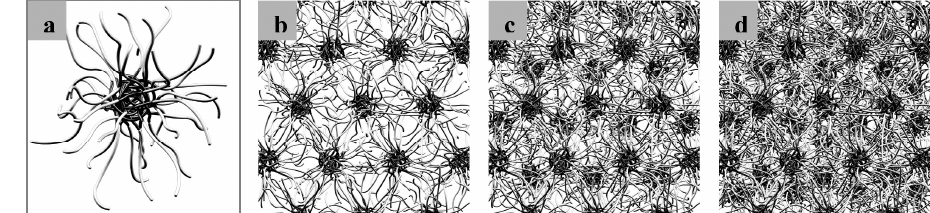
Figure 4. Schematic representations of Pluronic ® F127 micelles: ( a ) single micelle with spherical core-shell geometry; ( b ) single 2D hexagonally packed layer of micelles; ( c ) two 2D hexagonally packed layers of micelles (AB); and ( d ) three layers with ABC (or Faced Centered Cubic, FCC) stacking sequence structure. ( b – d ) correspond to the radial geometry. (Reprinted with permission from reference [32]. Copyright 2007 American Chemical Society).